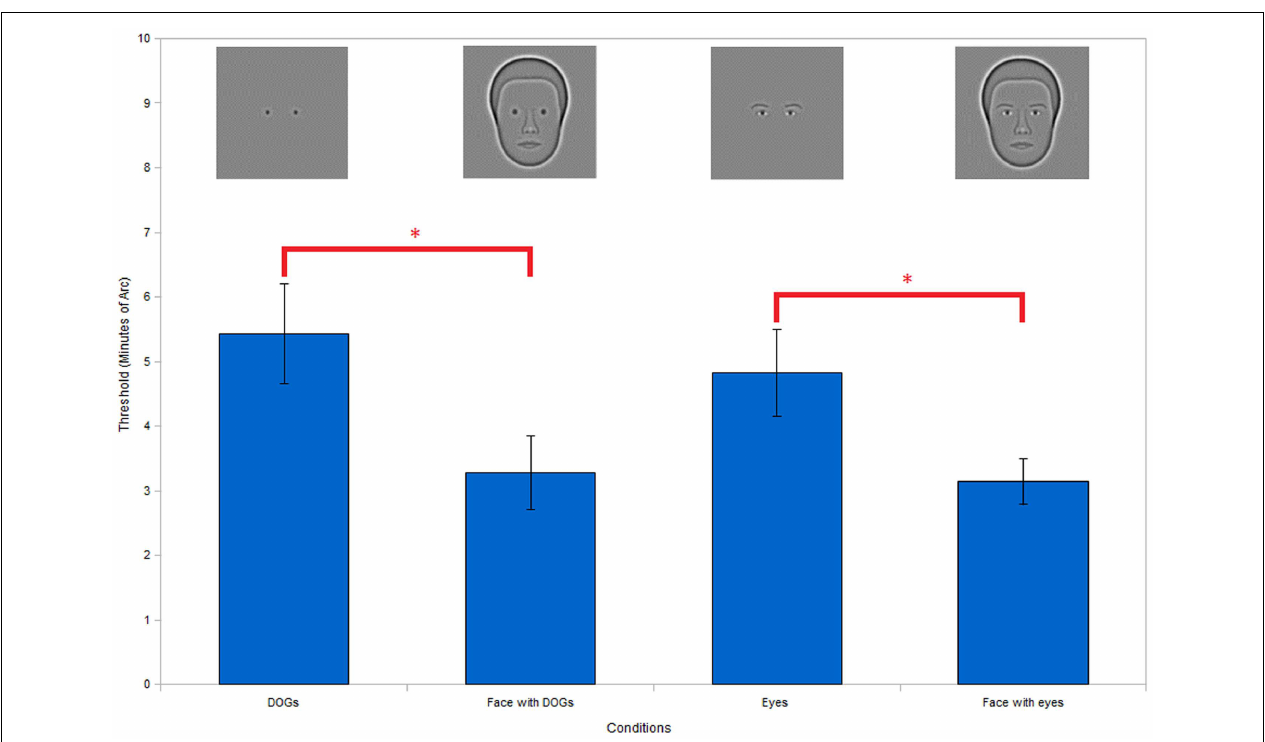
between DOGs and eyes. Both DOGs and eyes show significantly better performance within faces than in isolation, thus demonstrating clear face context effects. (** P < 0.01; * P <